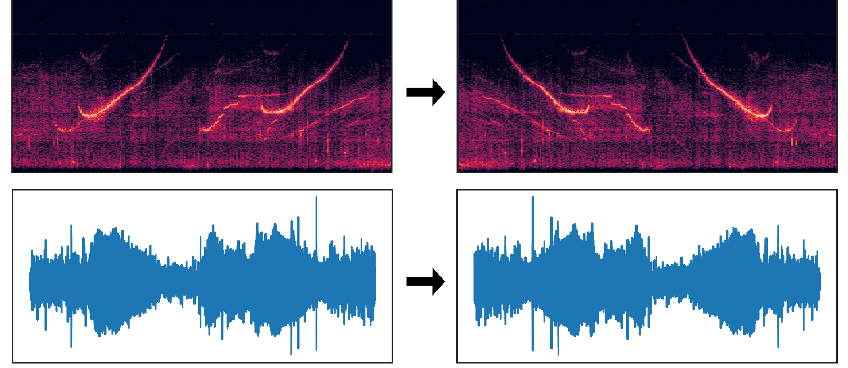
Figure 6. Data augmentation example.